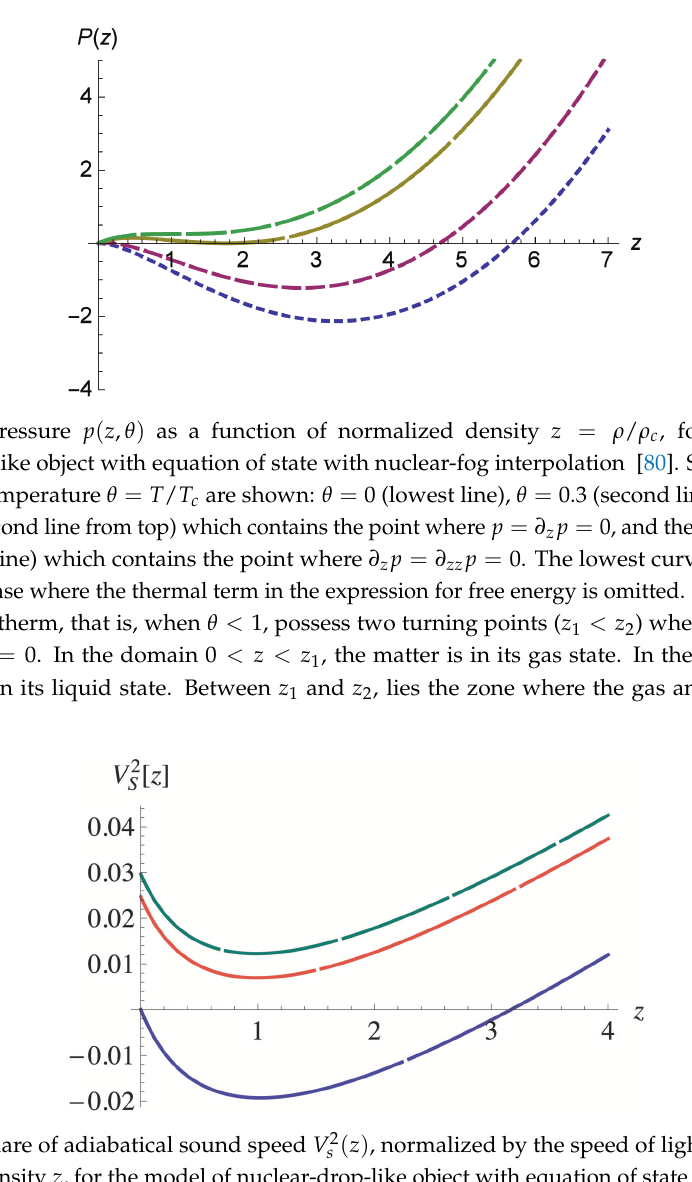
Figure 14. Square of adiabatical sound speed V 2 s ( z ) , normalized by the speed of light, as function of normalized density z , for the model of nuclear-drop-like object with equation of state with nuclear-fog interpolation [80]. Several values of normalized temperature θ = T / T c are shown: critical isotherm θ = 1 (upper line), θ (cid:39) 0.84 (above but close to touching horizontal axis), and θ = 0 (lower line). Domain with V 2 s ( z ) < 0 (where sound speed V s ( z ) is imaginary, i.e., the system is unstable) is the instability zone (within the spinodal zone) where small spontaneous initial perturbations of density grow exponentially fast once triggered. Development of instability in homogeneous medium leads to formation of two–phase pockets where liquid (drops) and gas (vapor) states co-exist. Only the states with temperatures below some temperature θ ∗ (unique for the medium), for which the curve V 2 s ( z ) touches the horizontal axis in plane ( z , V 2 s ), may experience such instability. For the states with θ > θ ∗ , the speed of sound is always real ( V 2 s ( z ) > 0) and the matter remains in its mono-phase